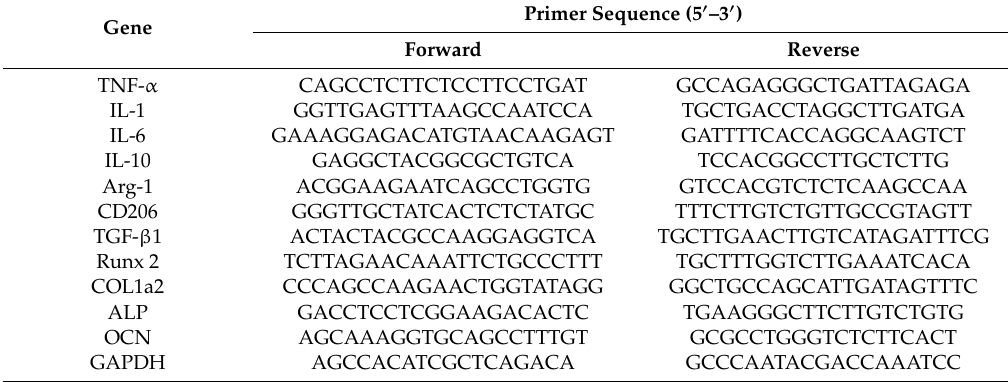
Table 1. Primers for quantitative